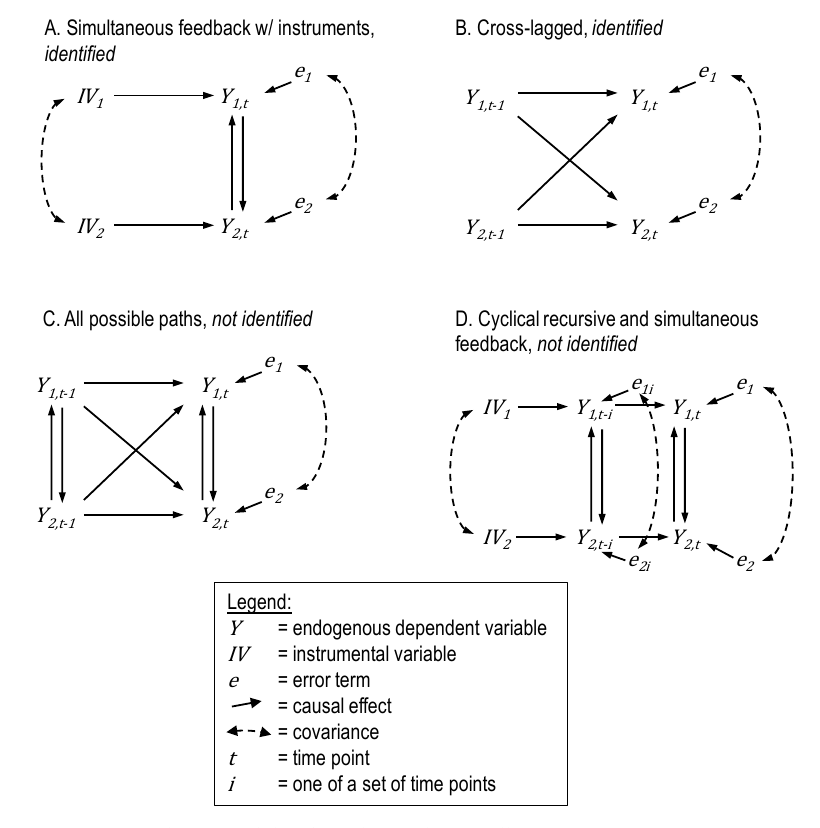
Figure 2 Various Models of Reciprocal